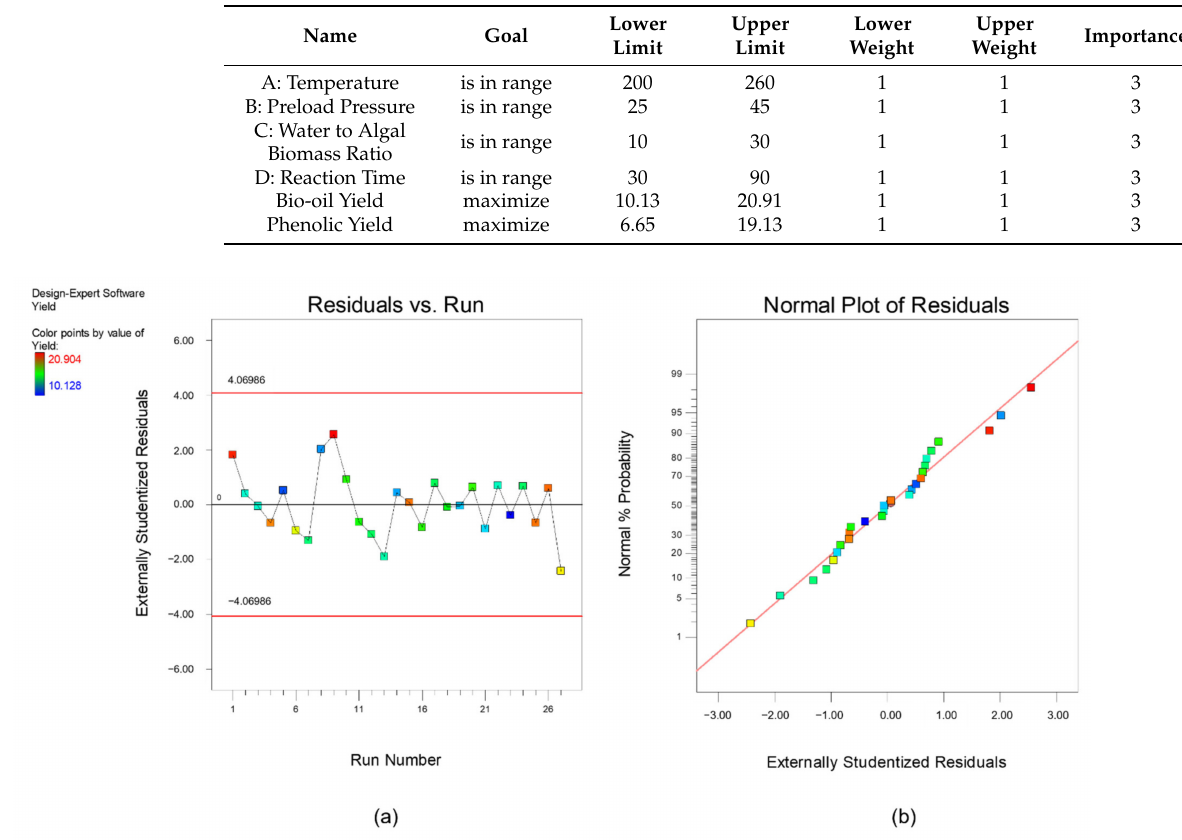
Table 9. Constraints for multi-objective optimization study.